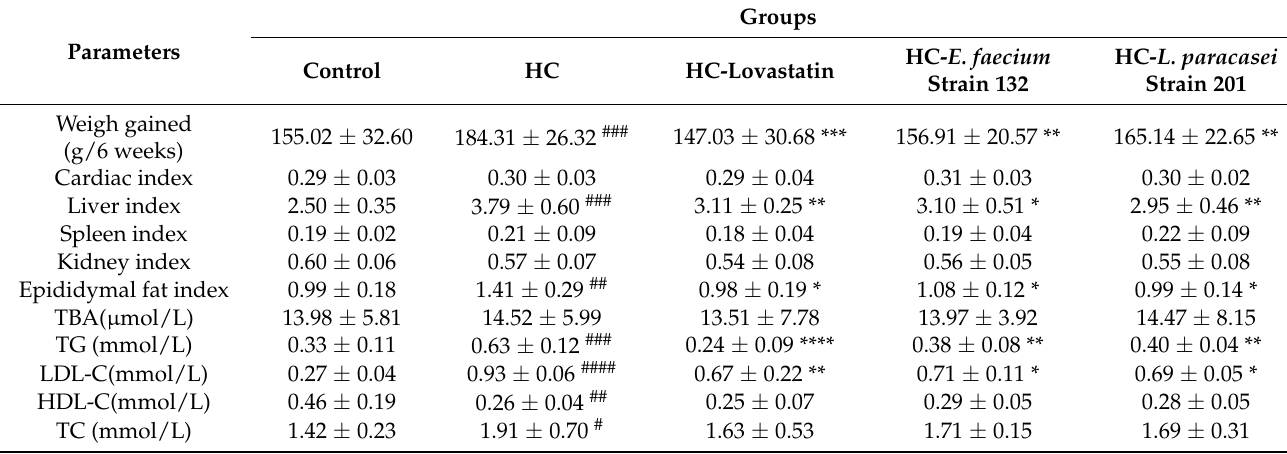
Table 2. The total weight gain, organ weight and blood biochemical index of rats in each